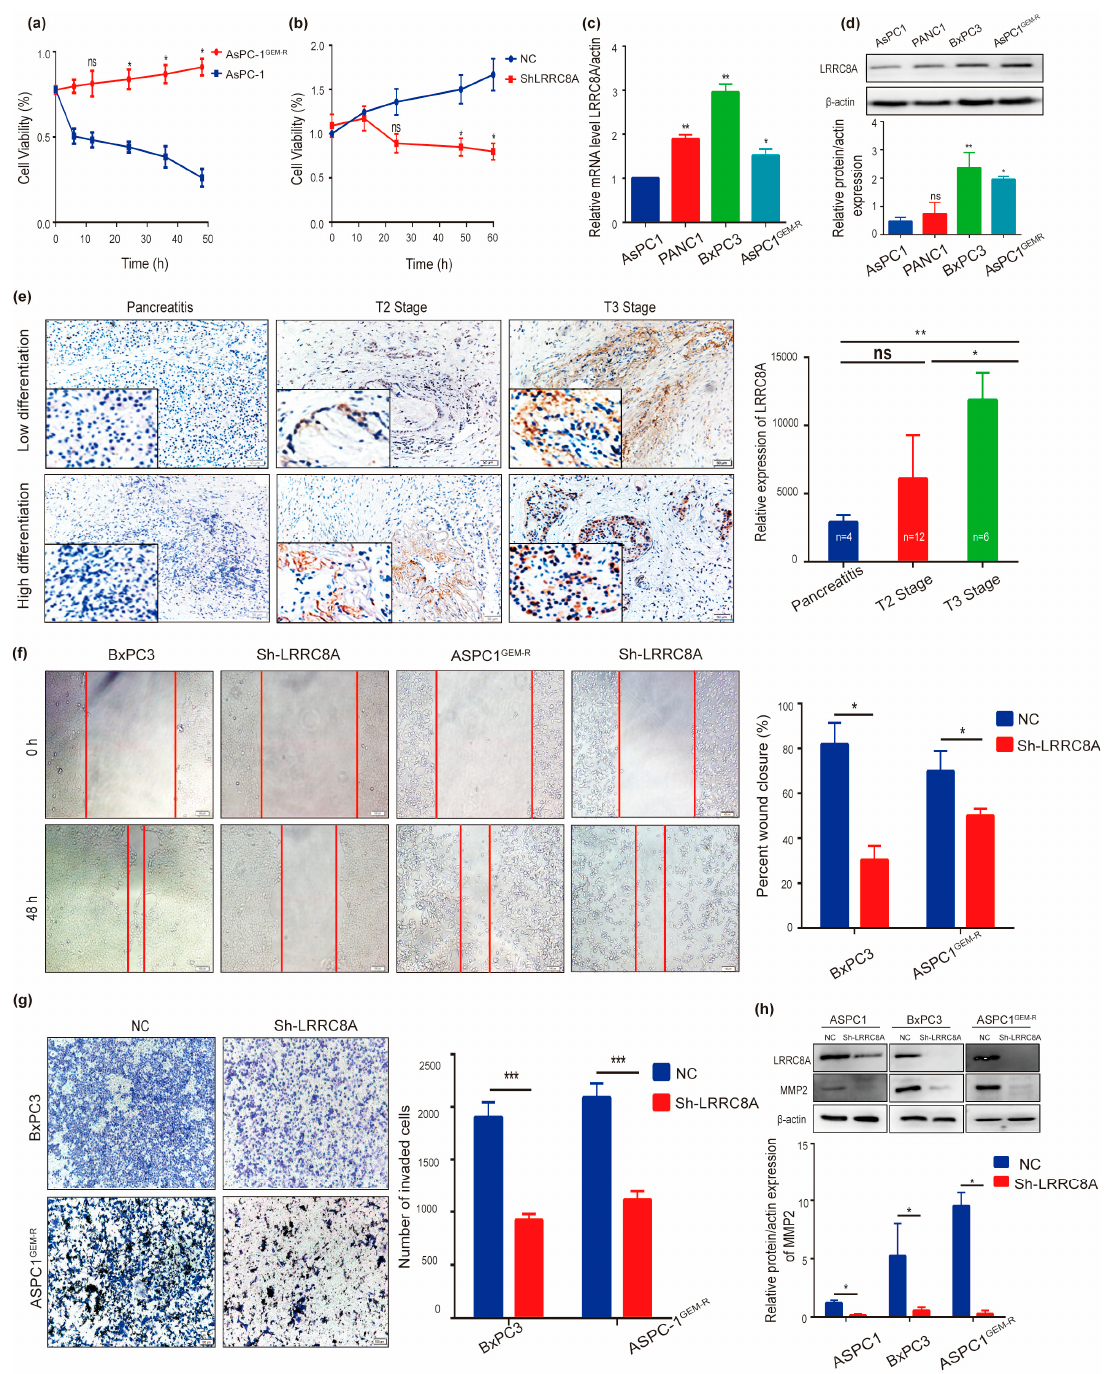
Figure 2. Roles of LRRC8A in PAAD in vitro. ( a ) Cell viability of AsPC-1 and AsPC-1 GEMR cells on GEM; ( b ) cell viability of AsPC-1 GEMR cells on GEM after pretreated with shLRRC8A or scramble lentivirus (NC); ( c ) mRNA expression of LRRC8A in PAAD cell lines; ( d ) LRRC8A protein expression in PAAD cell lines; ( e ) representative immunohistochemical results of LRRC8A in patients with PAAD and quantitative analysis results; ( f ) wound healing assay using BxPC-3 cells and AsPC-1 GEM-R cells with LRRC8A knockdown and quantitative analysis results; ( g ) transwell experiments using AsPC-1 and BxPC-3 cells, and quantitative analysis results; ( h ) expression of LRRC8A and MMP2 after AsPC-1, AsPC-1 GEM-R and BxPC-3 cells were treated by shLRRC8A. Error bars indicate SE. * p < 0.05, ** p < 0.01 and *** p < 0.001 by Student’s t-tests. The whole western blots were shown in File S1. ns: not